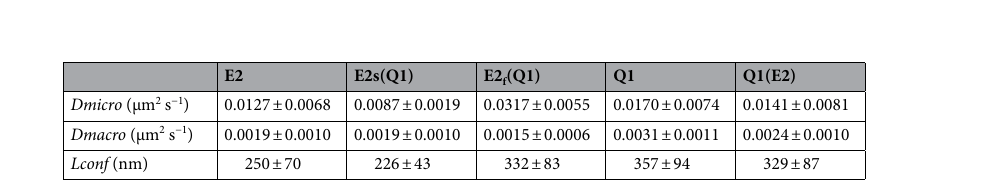
Table 2. List of iMSD parameters, values are mean